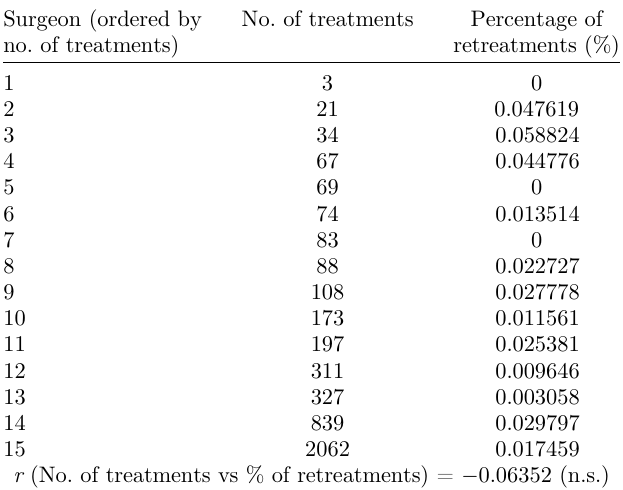
Table 2. Performance statistics for RS of Ophthalmica surgeons (see also Fig.